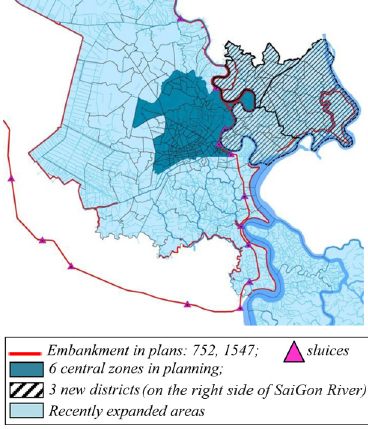
Figure 3. Flooding